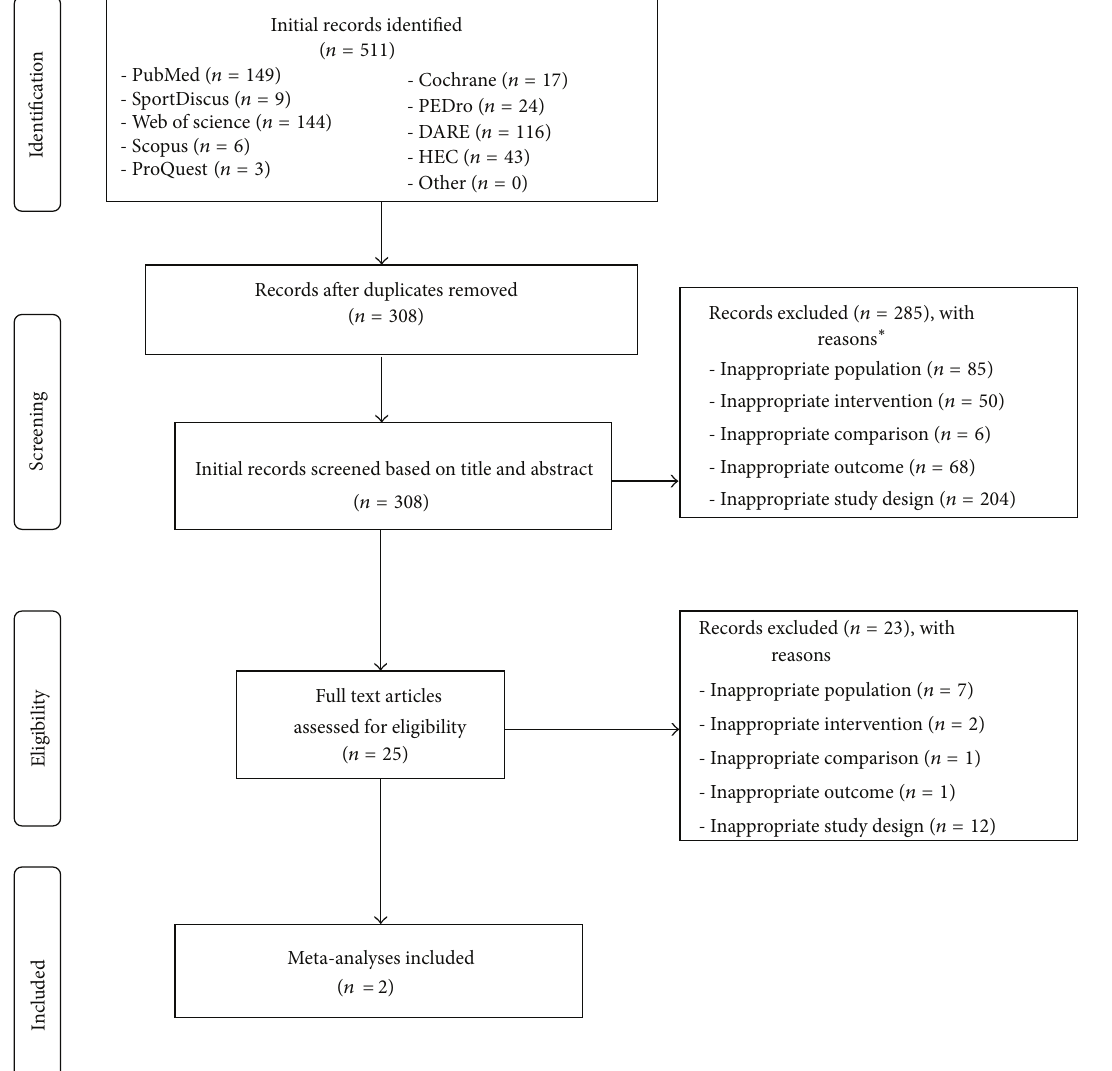
Figure 1: Flow diagram for selection of articles. ∗ Number of reasons exceeds number of records because some records are excluded for more than one